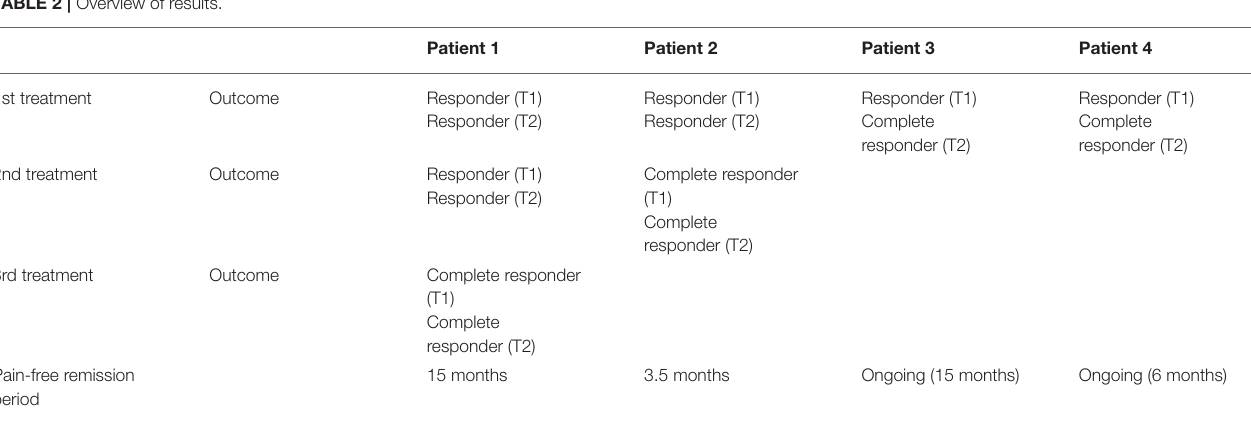
TABLE 2 | Overview of